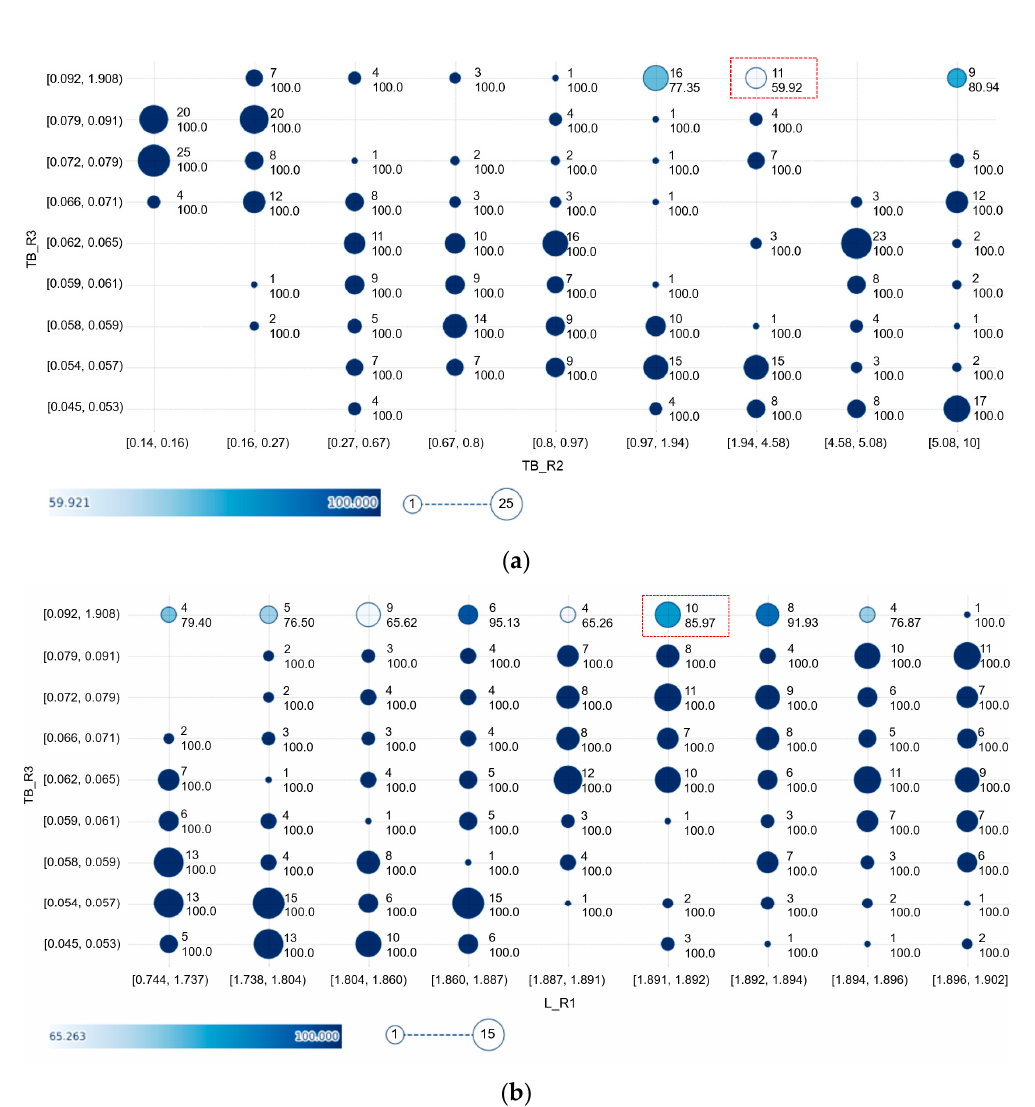
Figure 9. Target plot of R in the training data. ( a ) TB_R2 and TB_R3. ( b ) L_R1 and TB_R3.